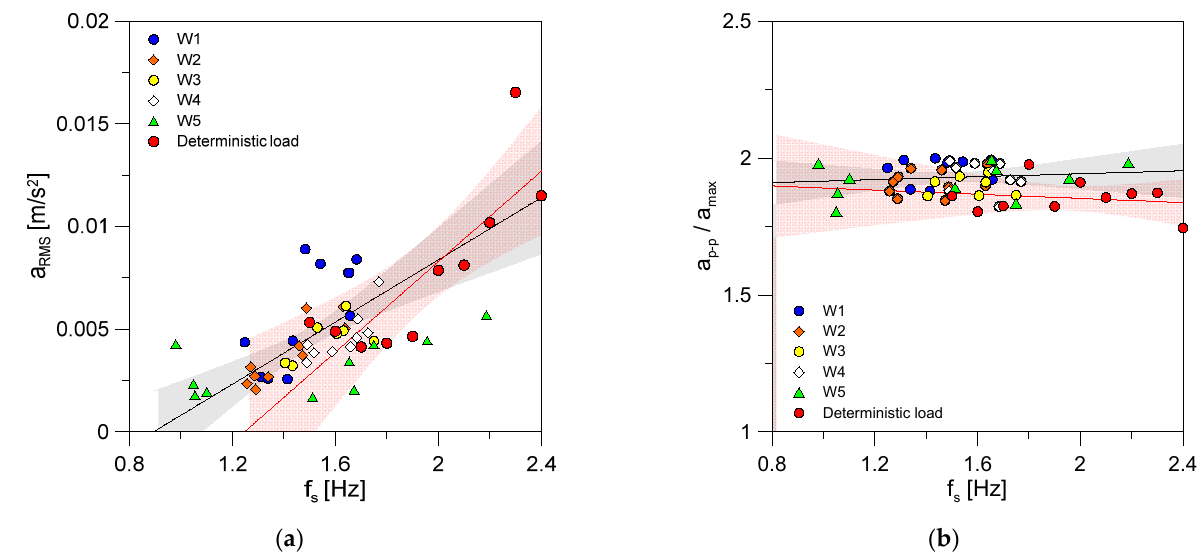
Figure 19. Summary of numerical performance indicators of the examined concrete slab under W1–W4 and W5 experimental body CoM accelerations or deterministic pedestrian loads (ABAQUS): ( a ) RMS value, and ( b ) peak-to-peak versus maximum acceleration. The 95% confidence interval is shown in grey and red colour, respectively. Table 6. Analysis of the examined concrete slab under W1–W5 experimental body CoM accelerations, with average values of maximum, RMS and peak-to-peak vertical accelerations of slab ( ± standard deviation) and R -square correlation